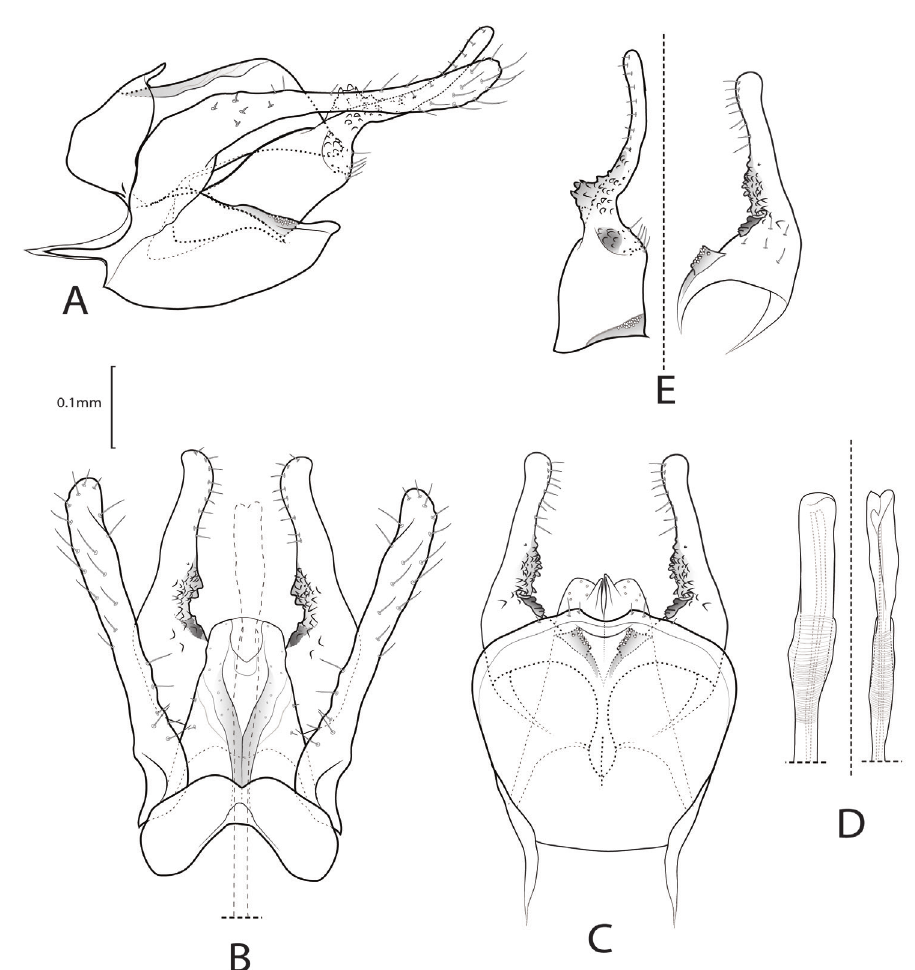
Figure 3. Xiphocentron ( Antillotrichia ) holzenthali sp. nov., holotype, adult, ♂ , genitalia A left lateral B dorsal C ventral D phallus left lateral and dorsal E detail of right inferior appendage mesal surface, lateral and ventral